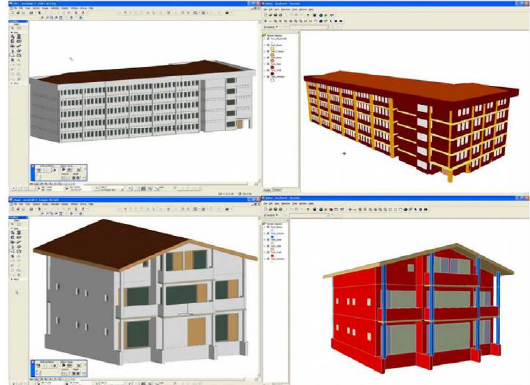
Figure 6. Different representations of two BIMs shown in both a CAD and a GIS.